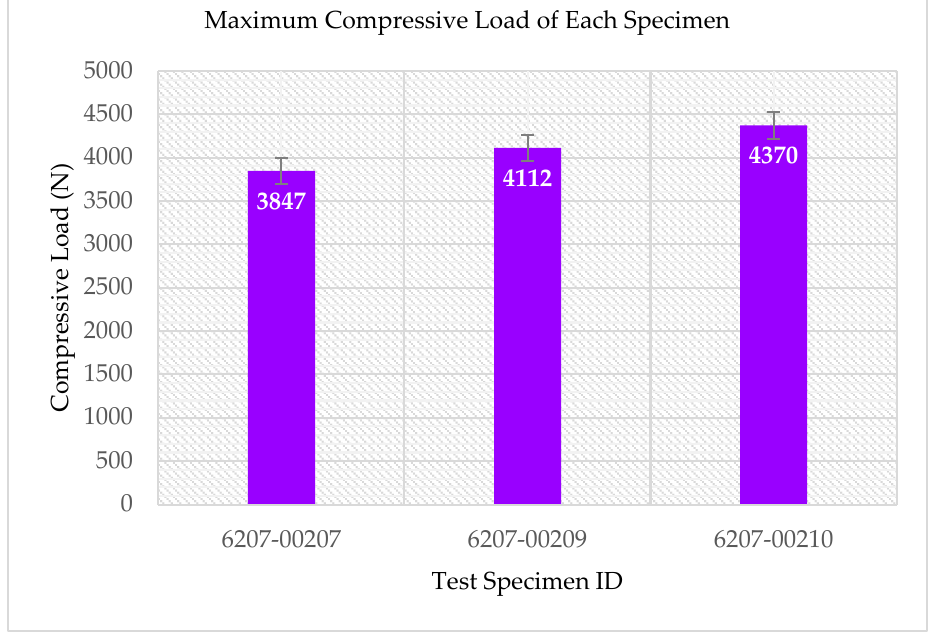
Figure 6. Maximum compressive load of each specimen after the RTD multifunctional Compressive ‐ Electrical test.